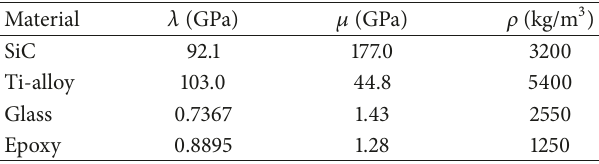
Table 1: Materials used in the current work [4, 13].